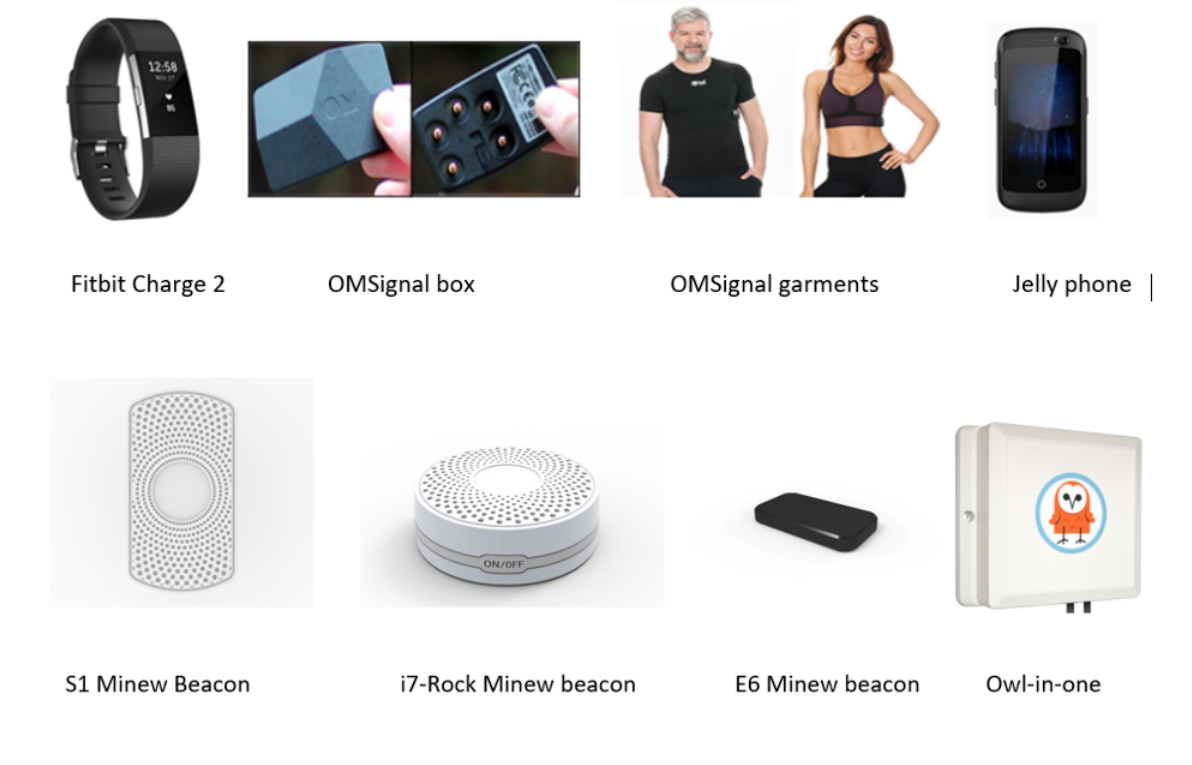
Table 2. Wearable and nonwearable sensors used in the Tracking Individual Performance with Sensors (TILES) study. Wearable sensors